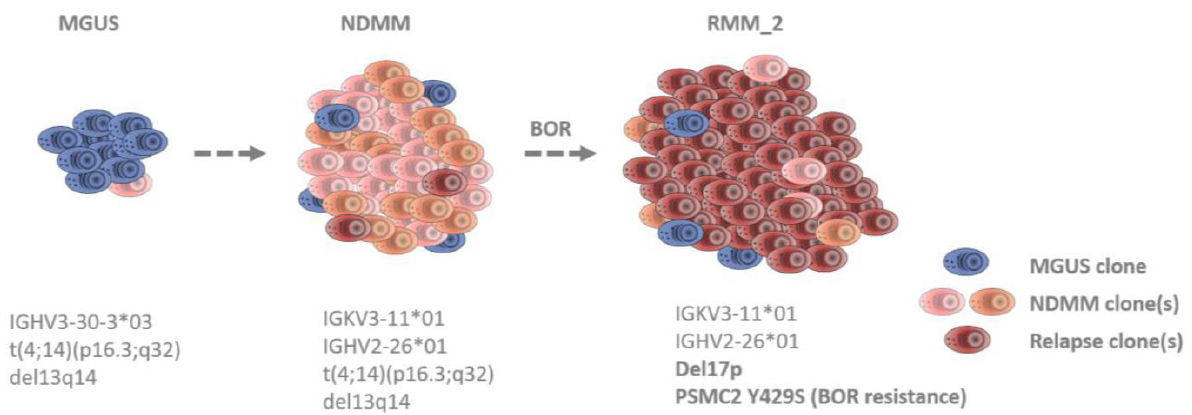
Figure 3. Clonal evolution in the index patients at different disease time points. The deep sequencing analysis of the index patient reveals that the tumor was composed of and dominated by different MM clones at the different time points: MGUS, NDMM, and RMM_2. At least three independent MM clones were confirmed by the IG rearrangement analysis, FISH, and WES.